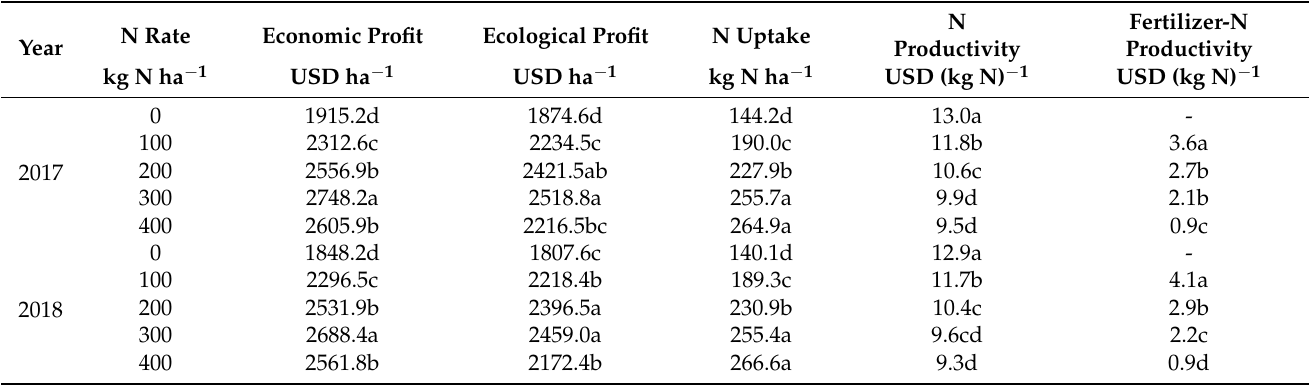
Table 3. Economic profit, ecological profit, N uptake, N productivity and fertilizer-N productivity in 2017 and 2018.